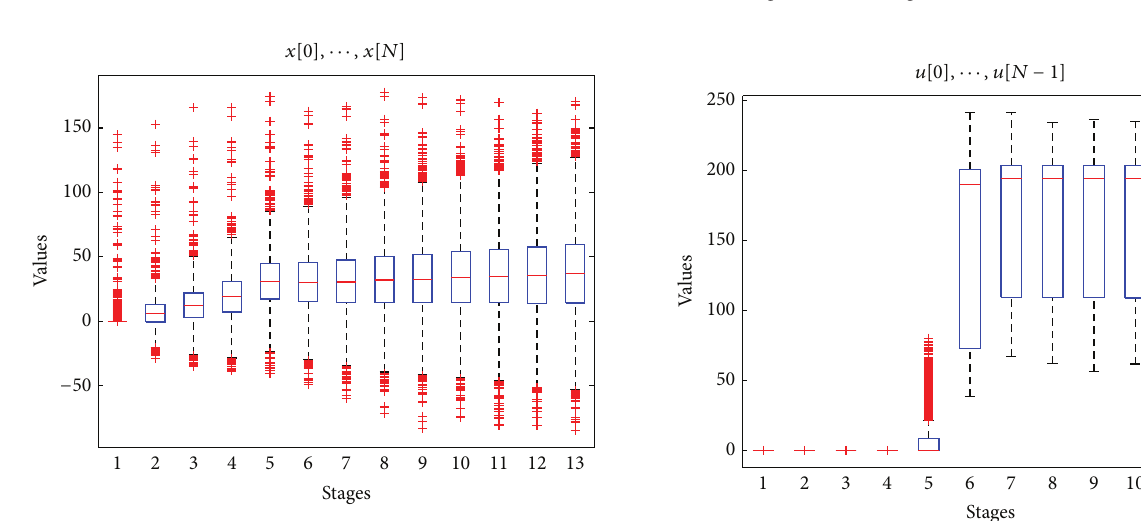
Figure 5: Case 1, Pareto front for a trade-off between the probabili- ties of having and not having stock.